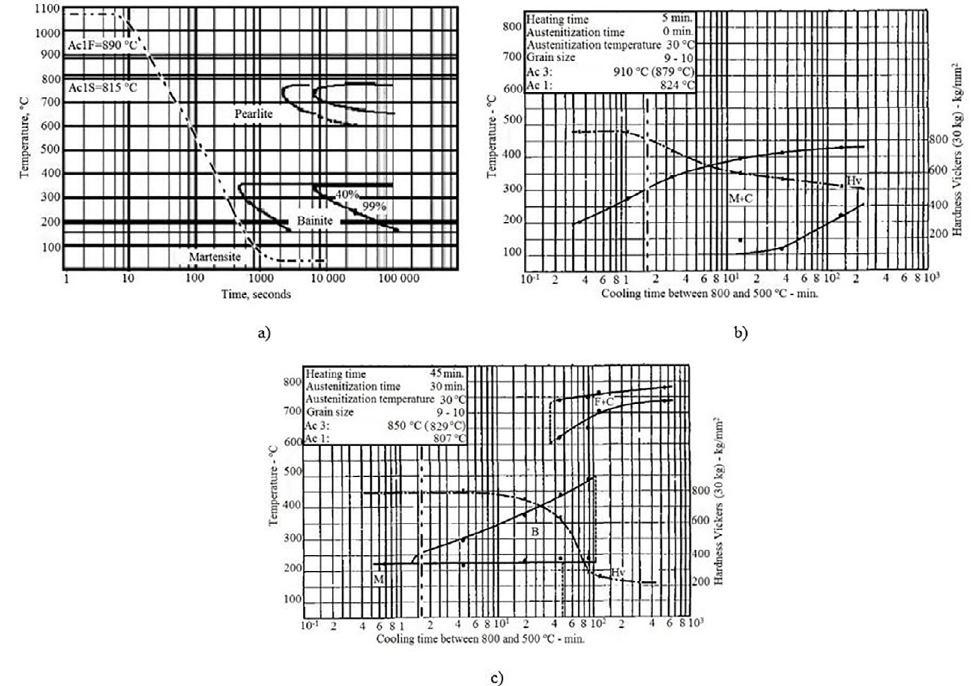
Figure 4. a) Isothermal transformation (I.T.) diagram for AISI M3:2 37 HSS, continuous cooling transformation diagram (C.C.T.) for b) AISI M2 HSS, and c) AISI D2 46 tool steel.